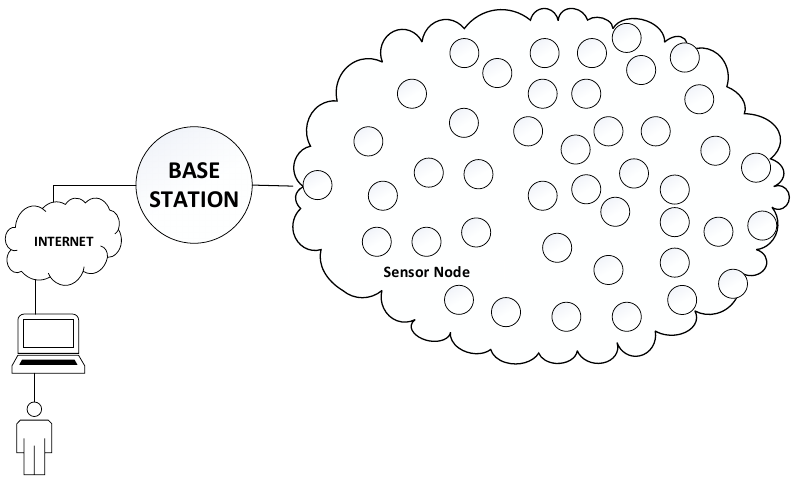
Figure 1. The general architecture of a WSN.